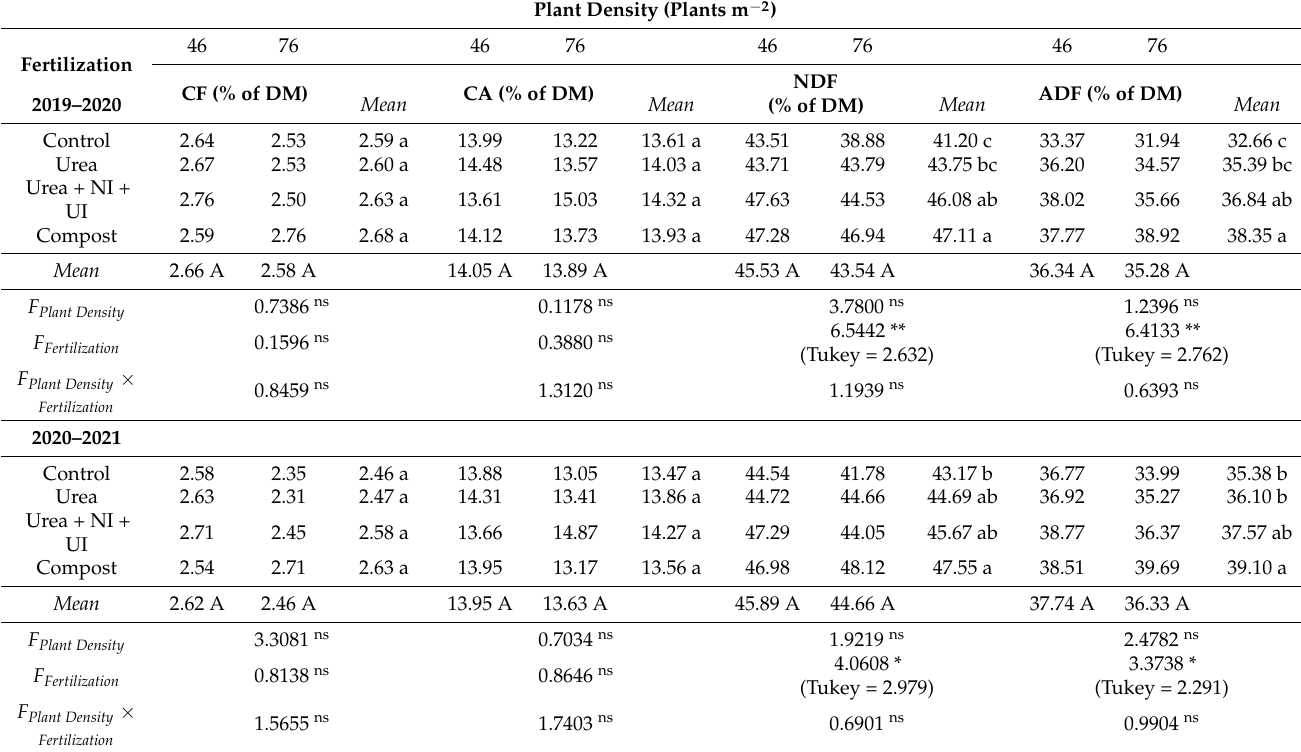
Table 3. Crude fat (CF), crude ash (CA), neutral detergent fiber (NDF), and acid detergent fiber (ADF) content as influenced by the plant density and